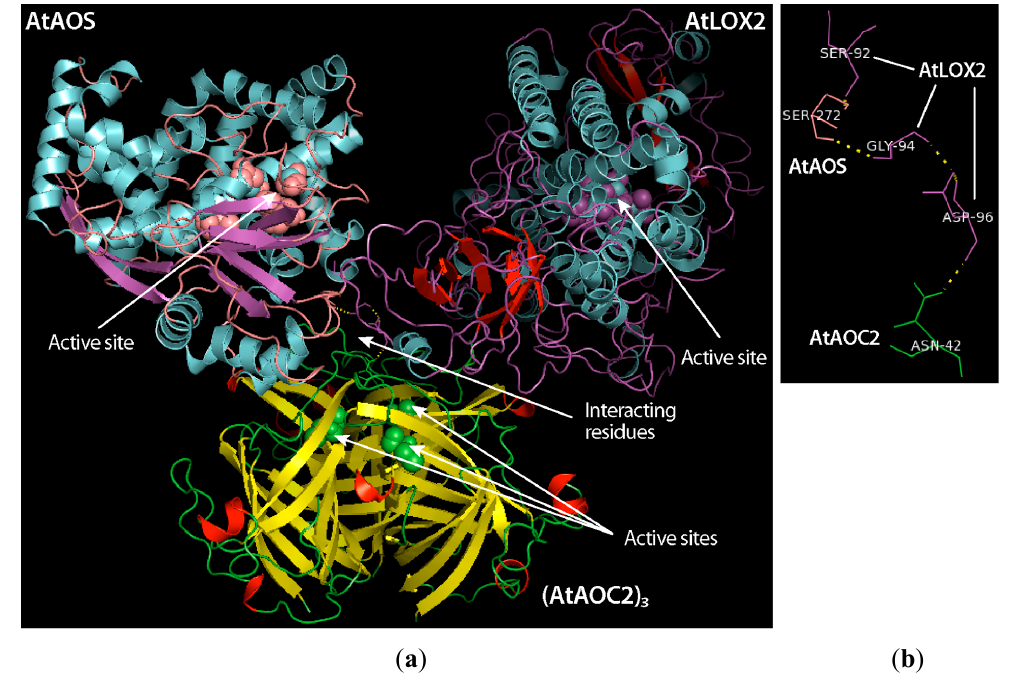
Figure 3. Structural model of the LOX2–AOS–AOC2 complex in chloroplasts. ( a ) Overall structure that was obtained by fitting the modelled LOX2 structures of Arabidopsis to the known X-ray structures of AOS [44] and AOC2 [32]. Amino acid residues suggested to be involved in catalysis of each enzyme as well as amino acid residues tentatively defined as residues mediating subunit interactions are indicated. ( b ) Cartoon highlighting the different amino acid pairs implicated in the different protein–protein interactions. Table 1. Amino acids identified to be potentially implicated in LOX2–AOS–AOC2 complex formation. Amino Acid Interactions Observed in the